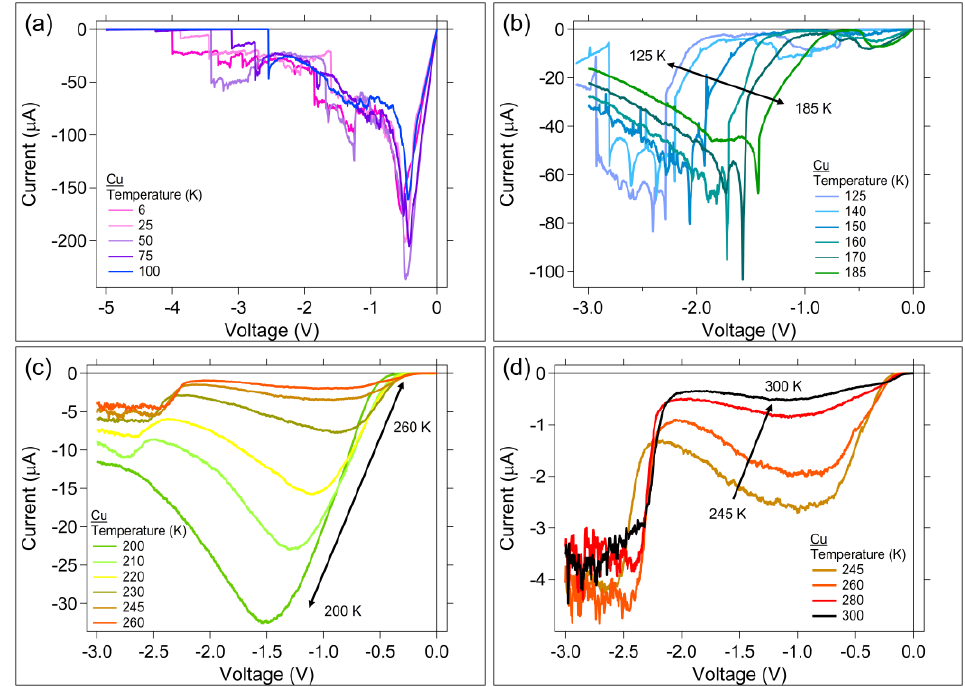
Figure 4. Cu device erase regions for ( a ) 6 K ≤ T ≤ 100 K; ( b ) 125 K ≤ T ≤ 185 K; ( c ) 260 K ≤ T ≤ 200 K; and ( d ) 245 K ≤ T ≤ 300 K.